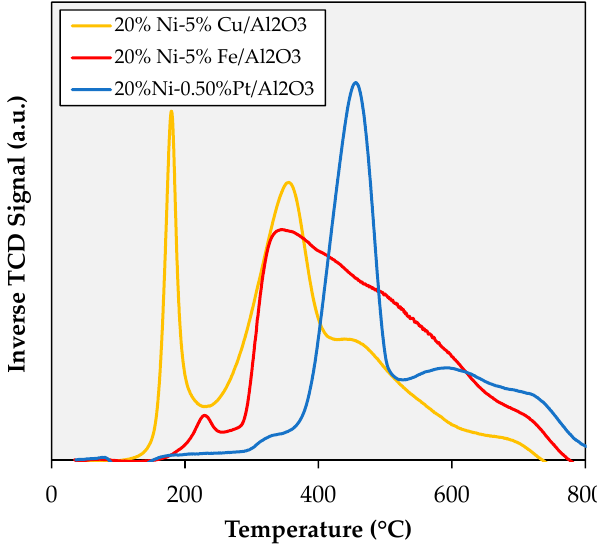
Figure 4. TPR profiles of the catalysts studied.